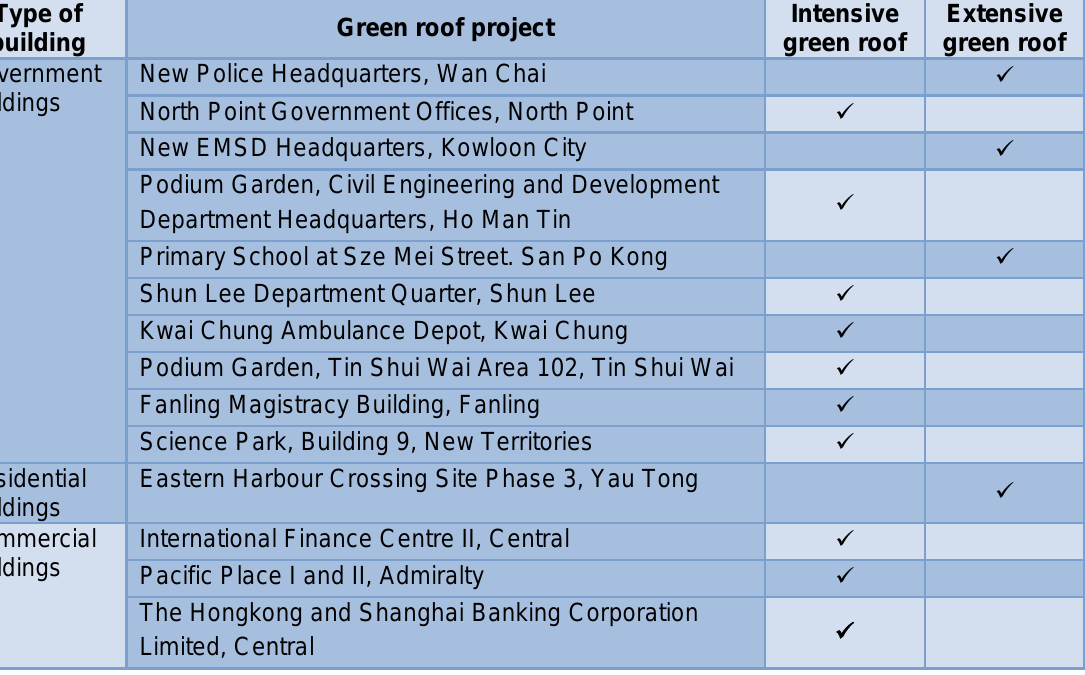
Table 5 Examples of Hong Kong Green Roof Projects (Urbis Limited 2007) From the above cases, it can be seen that applications of the extensive green roofs